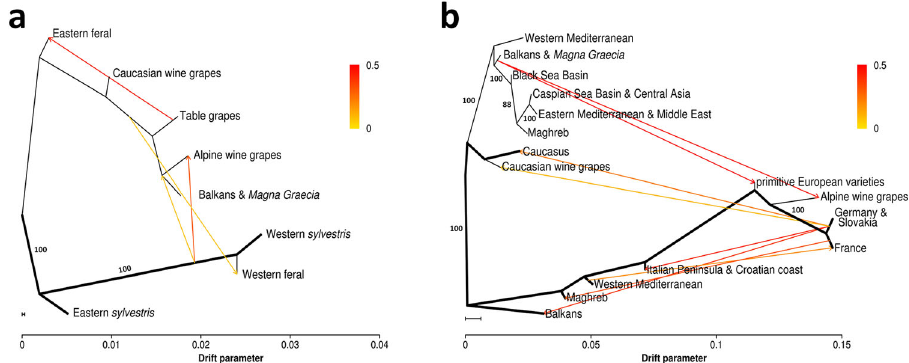
Fig. 1 Split and admixture events in groups de fi ned by population structure in the WGS panel (a) and by geographic distribution in the diversity panel (b). a Maximum likelihood (ML) tree with four groups of cultivated varieties (Supplementary Fig. 10) and four groups of wild accessions (Supplementary Fig. 7). Ancestry composition and group sizes are illustrated in Supplementary Fig. 10. b ML tree with nine groups of cultivated varieties and seven populations of sylvestris . Ancestry composition, group sizes, explained variance and the description of sylvestris – sylvestris admixture are given in Supplementary Fig. 22. a , b Migration events are indicated by colored arrows. The color scale shows the migration weight. The scale bar shows ten times the average standard error of the estimated entries in the sample covariance matrix. Bold lines indicate the sylvestris branches of the tree. Trees represent random trees and numbers represent bootstrap support values above 70% (100 iterations) before adding migrations. Support for the migration events and the resulting predictive model is given in Supplementary Figs. 20 and 22c, Supplementary Table 1, and Supplementary Data